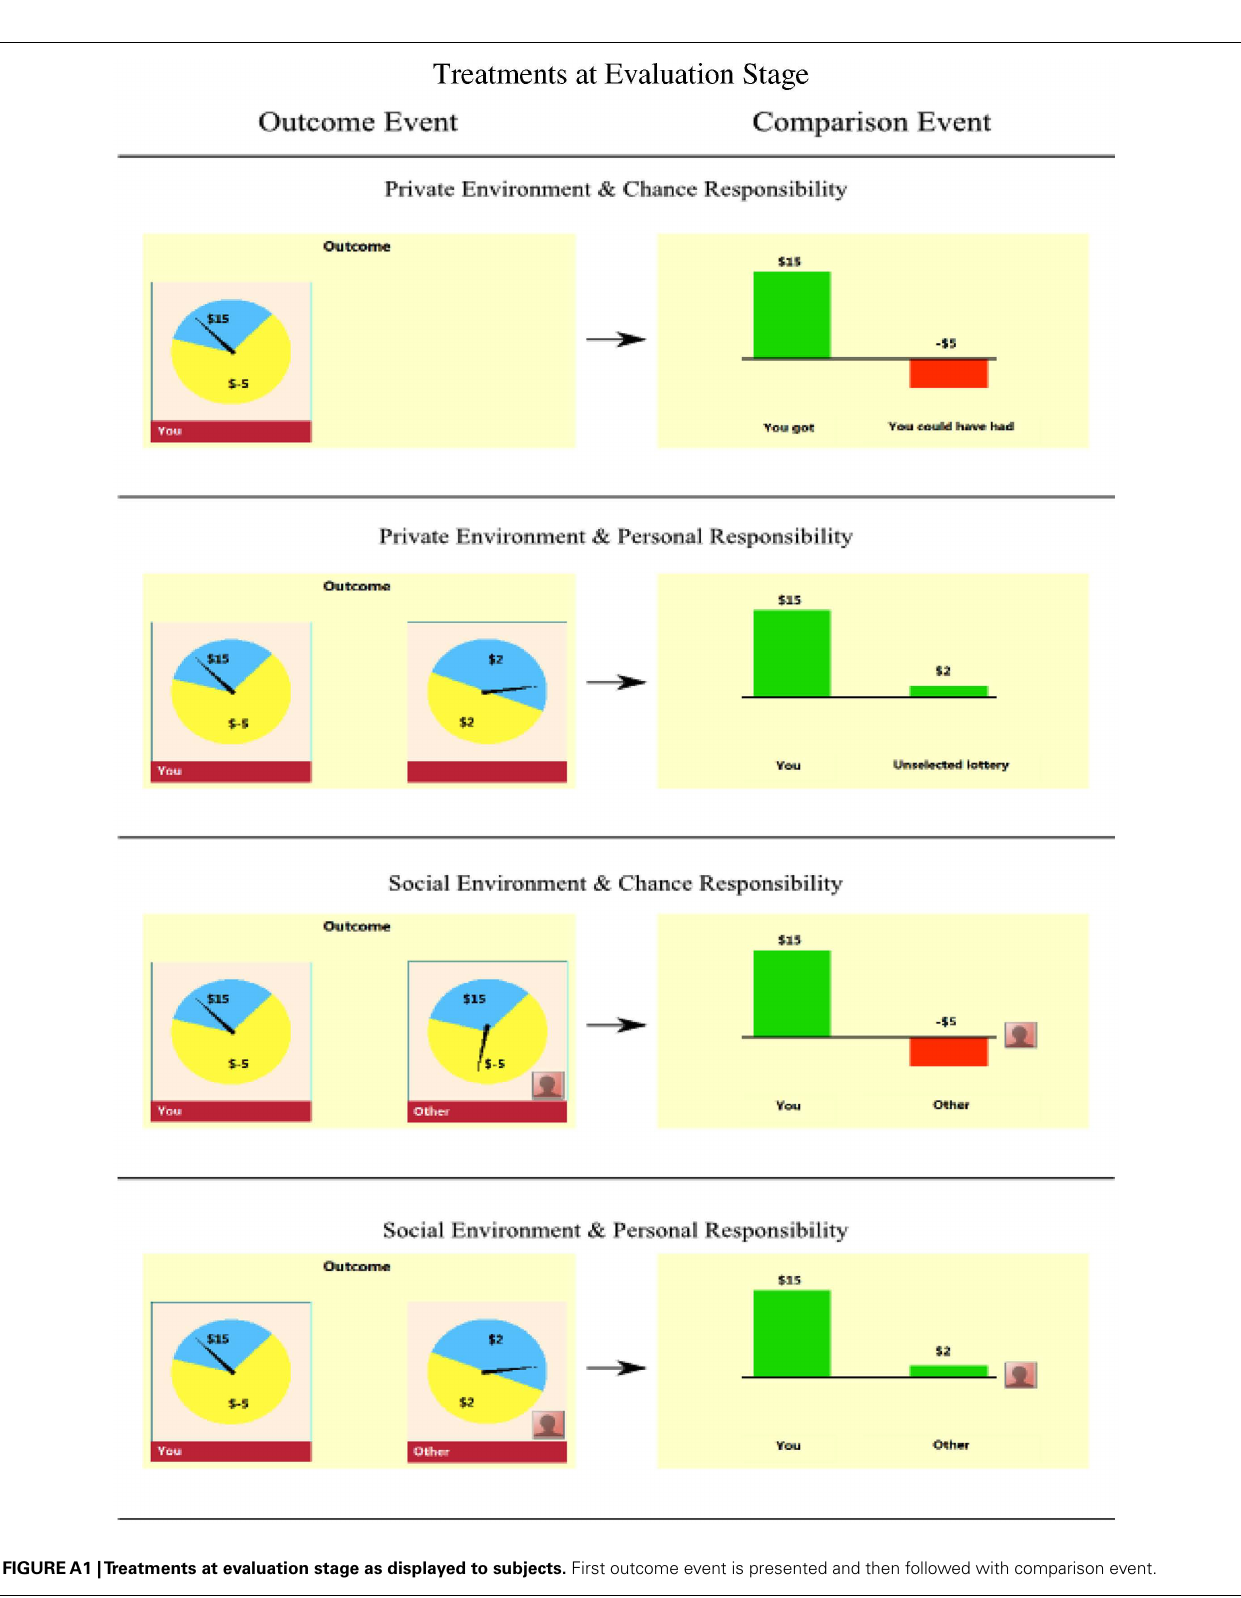
FIGUREA1 |Treatments at evaluation stage as displayed to subjects. First outcome event is presented and then followed with comparison event.